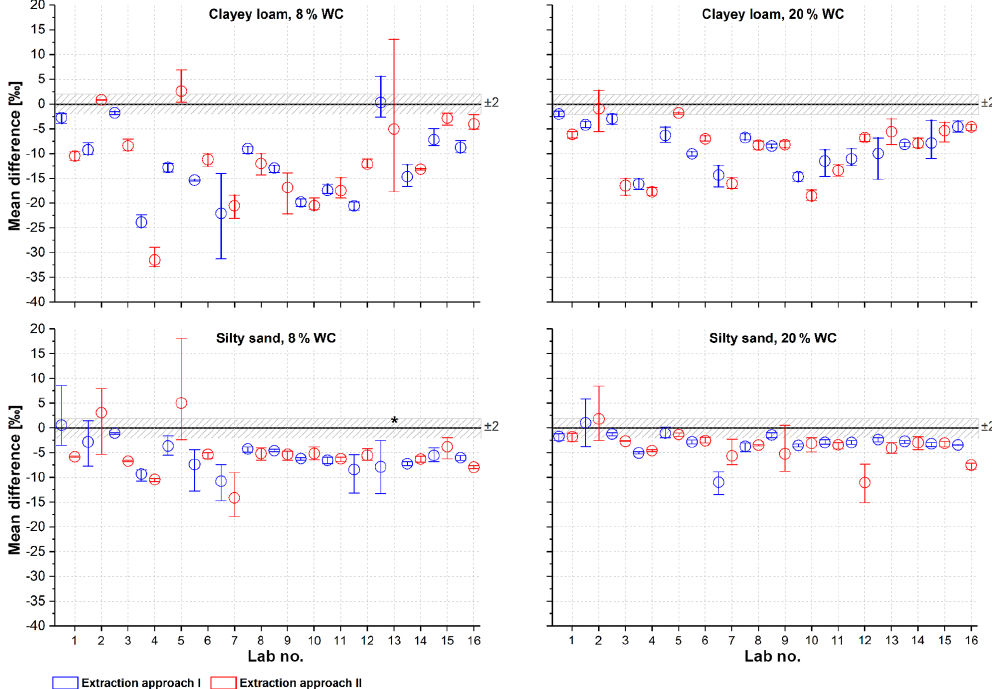
Figure 3. Mean differences from reference DI water for δ 2 H OA-ICOS results of water extracts from both extraction methods (lab procedure: I; predefined: II), soil types, and water contents (8 and 20%WC) including TSD of ± 2 for δ 2 H (Asterisk: − 108.4 for δ 2 H). Symbols represent the mean of the three replicates and y error bars stand for the isotopic variation of the replicates. There were no significant differences between the two extraction approaches over all